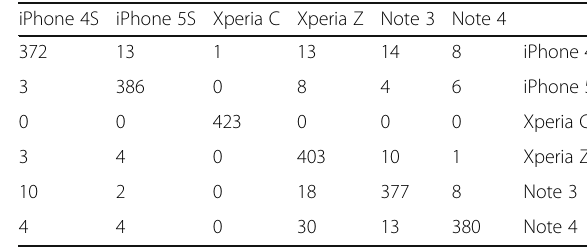
Table 9 Confusion matrix for 3